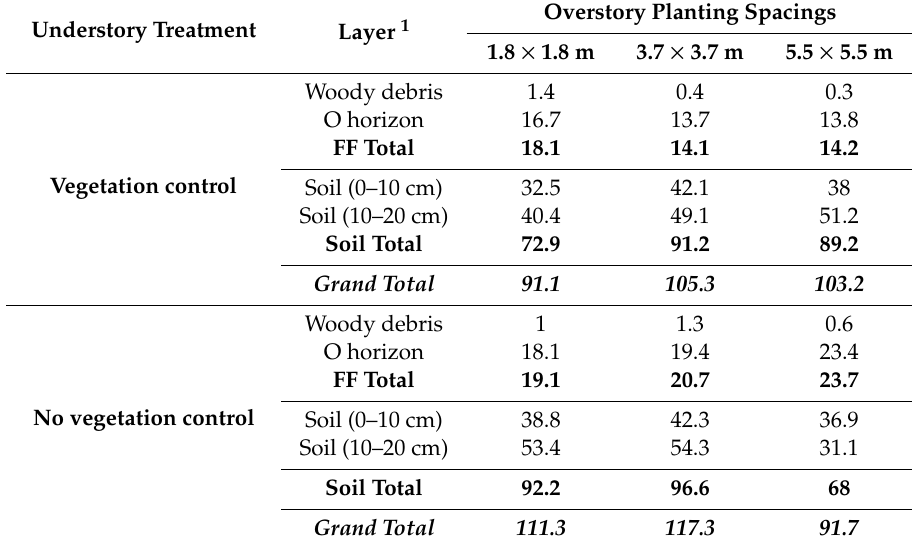
Table 2. 28-year-old ponderosa pine plantation detrital carbon pools (Mg C ha − 1 ) at Challenge Experimental Forest, California. Treatments are three levels of planted spacings of pine and two vegetation controls of understory in a split plot